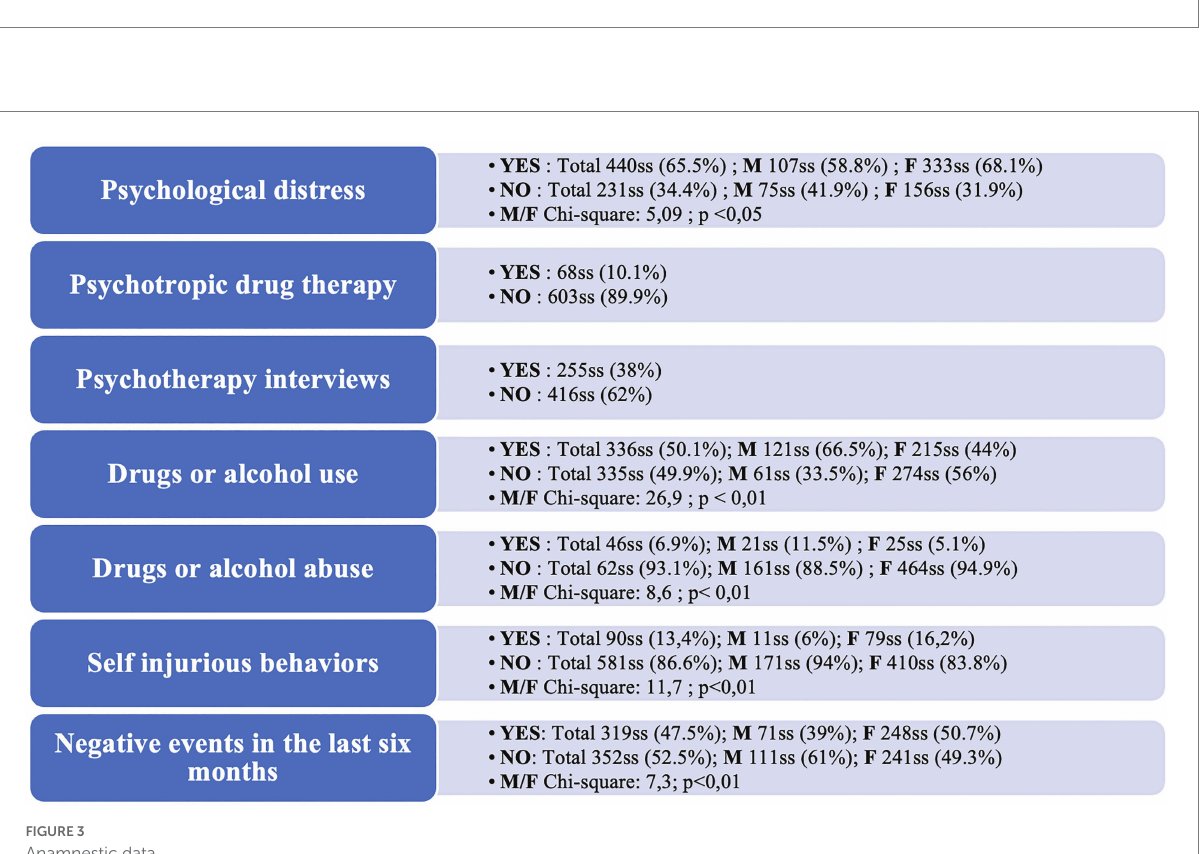
FIGURE 3 Anamnestic